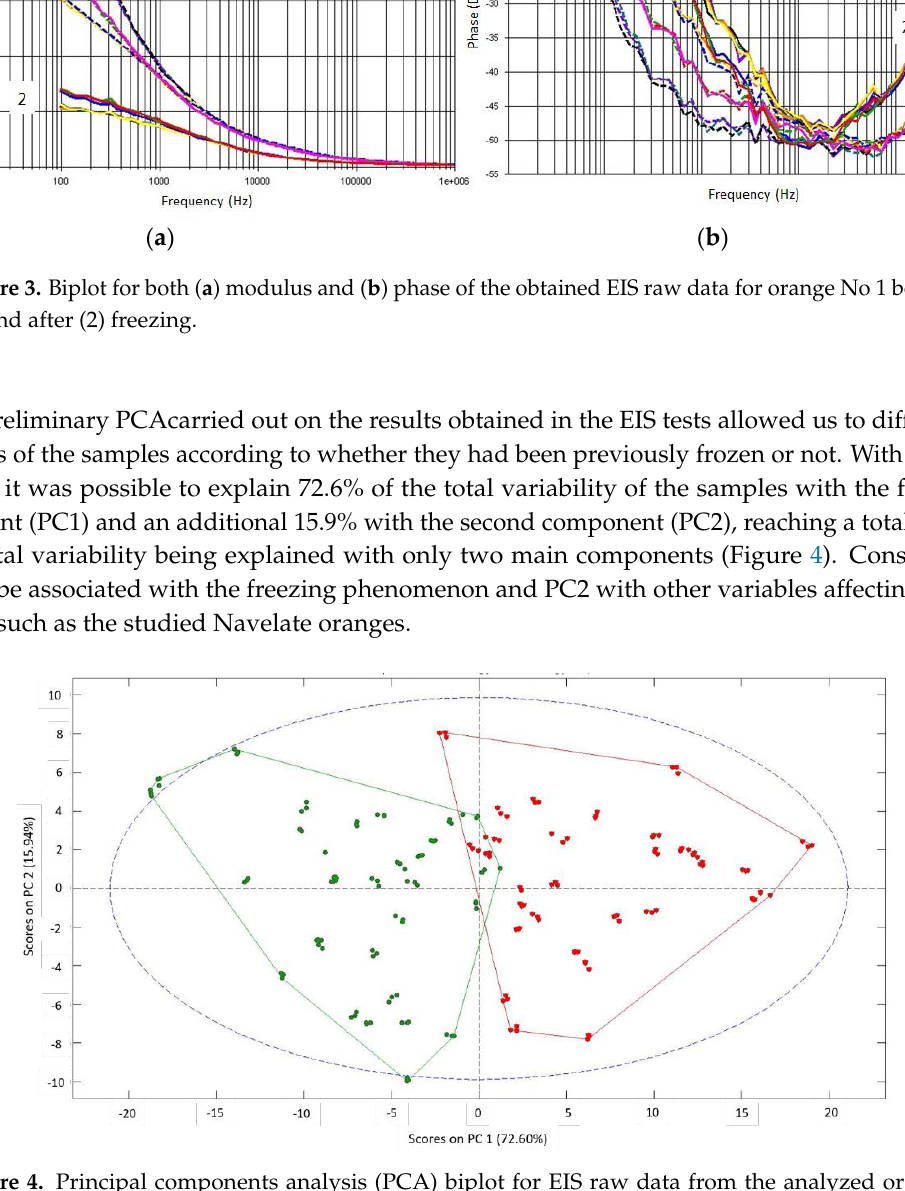
Figure 4. Principal components analysis (PCA) biplot for EIS raw data from the analyzed orange samples: green triangles represent natural (i.e., unfrozen) samples, and red triangles represent those having experienced a freeze phenomenon.